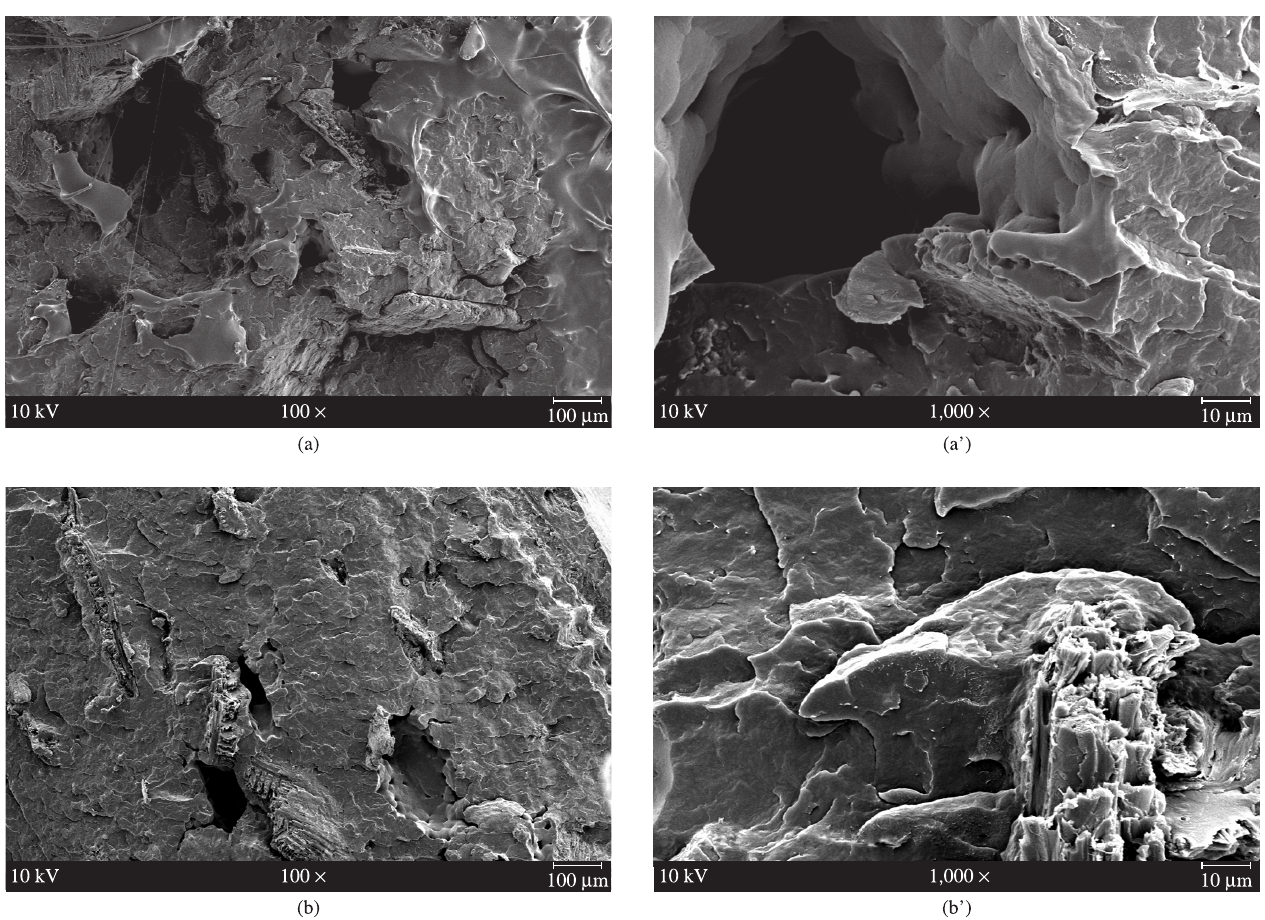
Figure 7. SEM micrographs of brittle-fractured surfaces of composites with 20 wt. (%) RHF: a) without MAPP; b) with